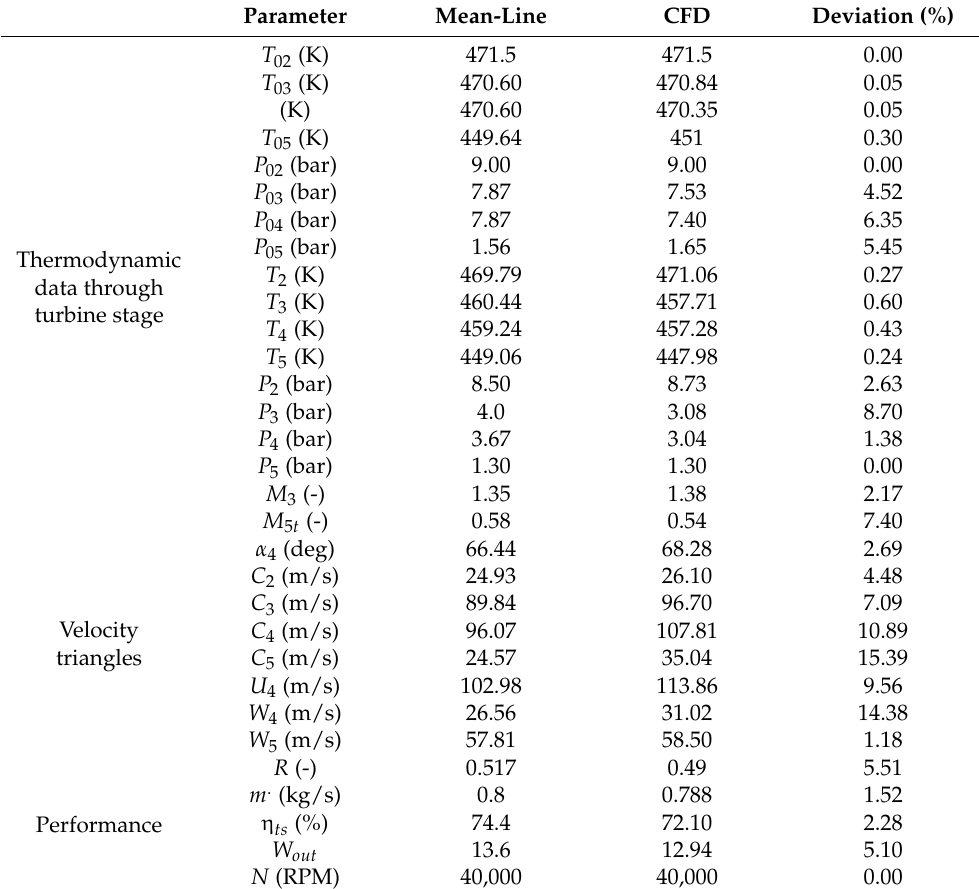
Table 6. Comparison between 1D mean-line and CFD